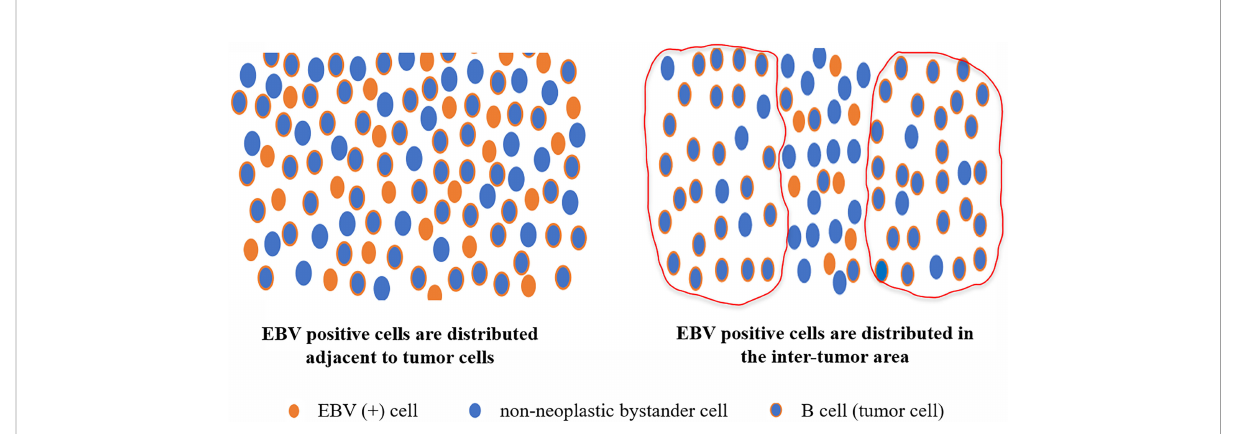
FIGURE 5 Distribution pattern of EBER-positive cells in MCL with EBER positivity. According to their morphology, immunohistochemistry, and location, most EBER-positive cells in MCL were not tumor cells, and most of the EBV-infected cells were background cells in